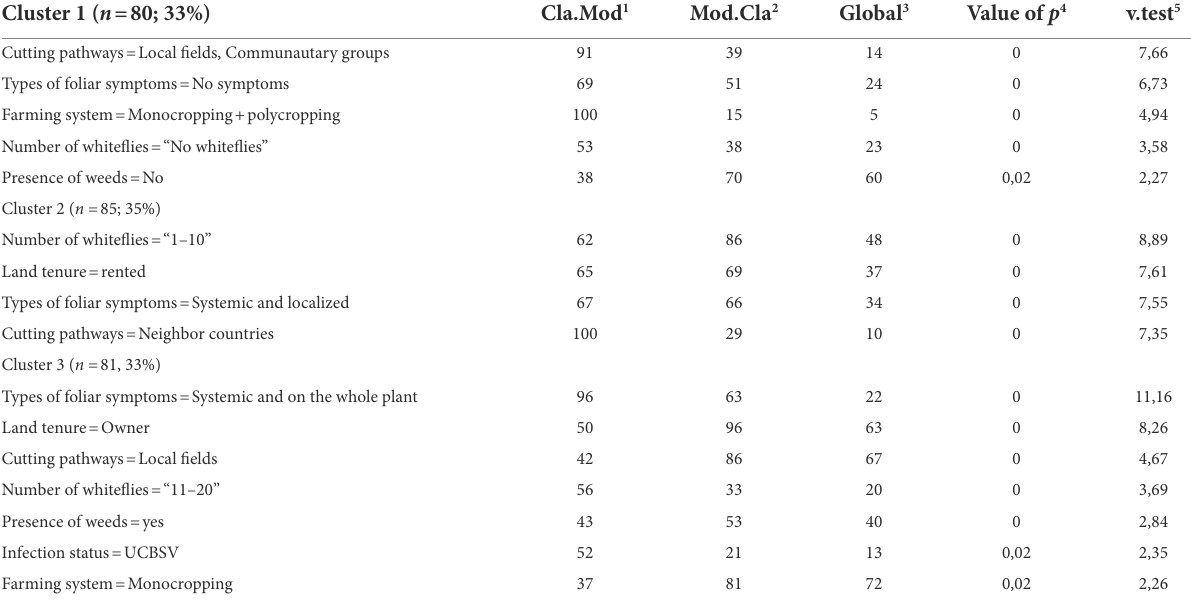
TABLE 3 Categorical variables associated with the description of clusters from HCPC analysis. Cluster 1 ( n = 80;